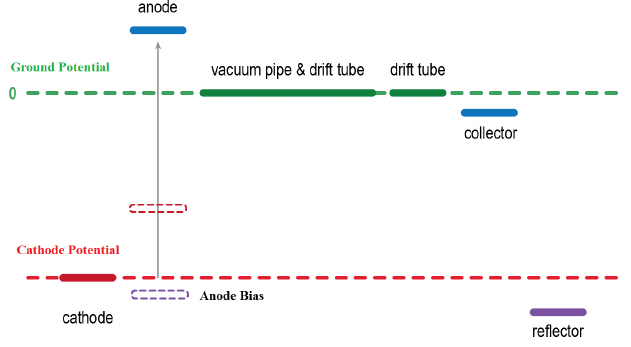
FIG. 10. Diagram of the RHIC e -lens